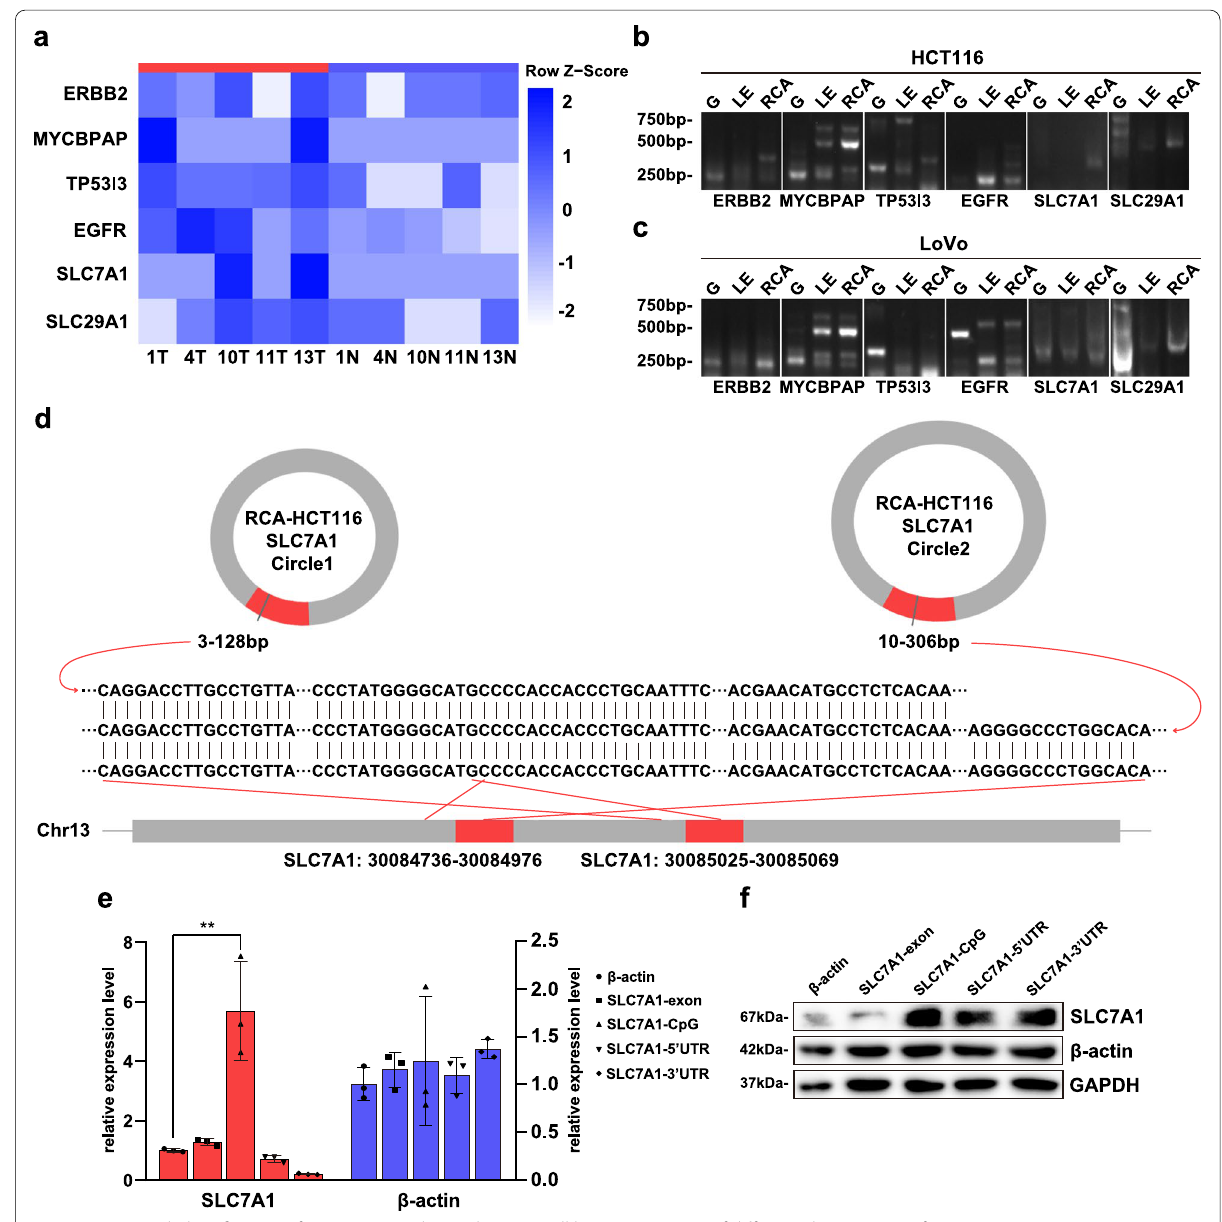
Fig. 5 Functional identification of eccDNAs in colorectal cancer cell lines. a Heatmap of differential expression of genes REBB2, MYCBPAP, TP53I3, EGFR, SLC7A1, SLC29A1 in the samples. b - c DNA electrophoresis of inverse PCR for genes in Fig. 5a to verify eccDNA in HCT116 and Lovo respectively. G: genome DNA. LE: total DNA with linear DNA elimination. RCA: total DNA with linear DNA elimination after RCA. d Schematic representation of the sequencing results of PCR products of gene SLC7A1 in samples after RCA with matching the sequence in chr13. e - f Relative mRNA expression and protein levels of SLC7A1 and β-actin in HCT116 transfected synthetic